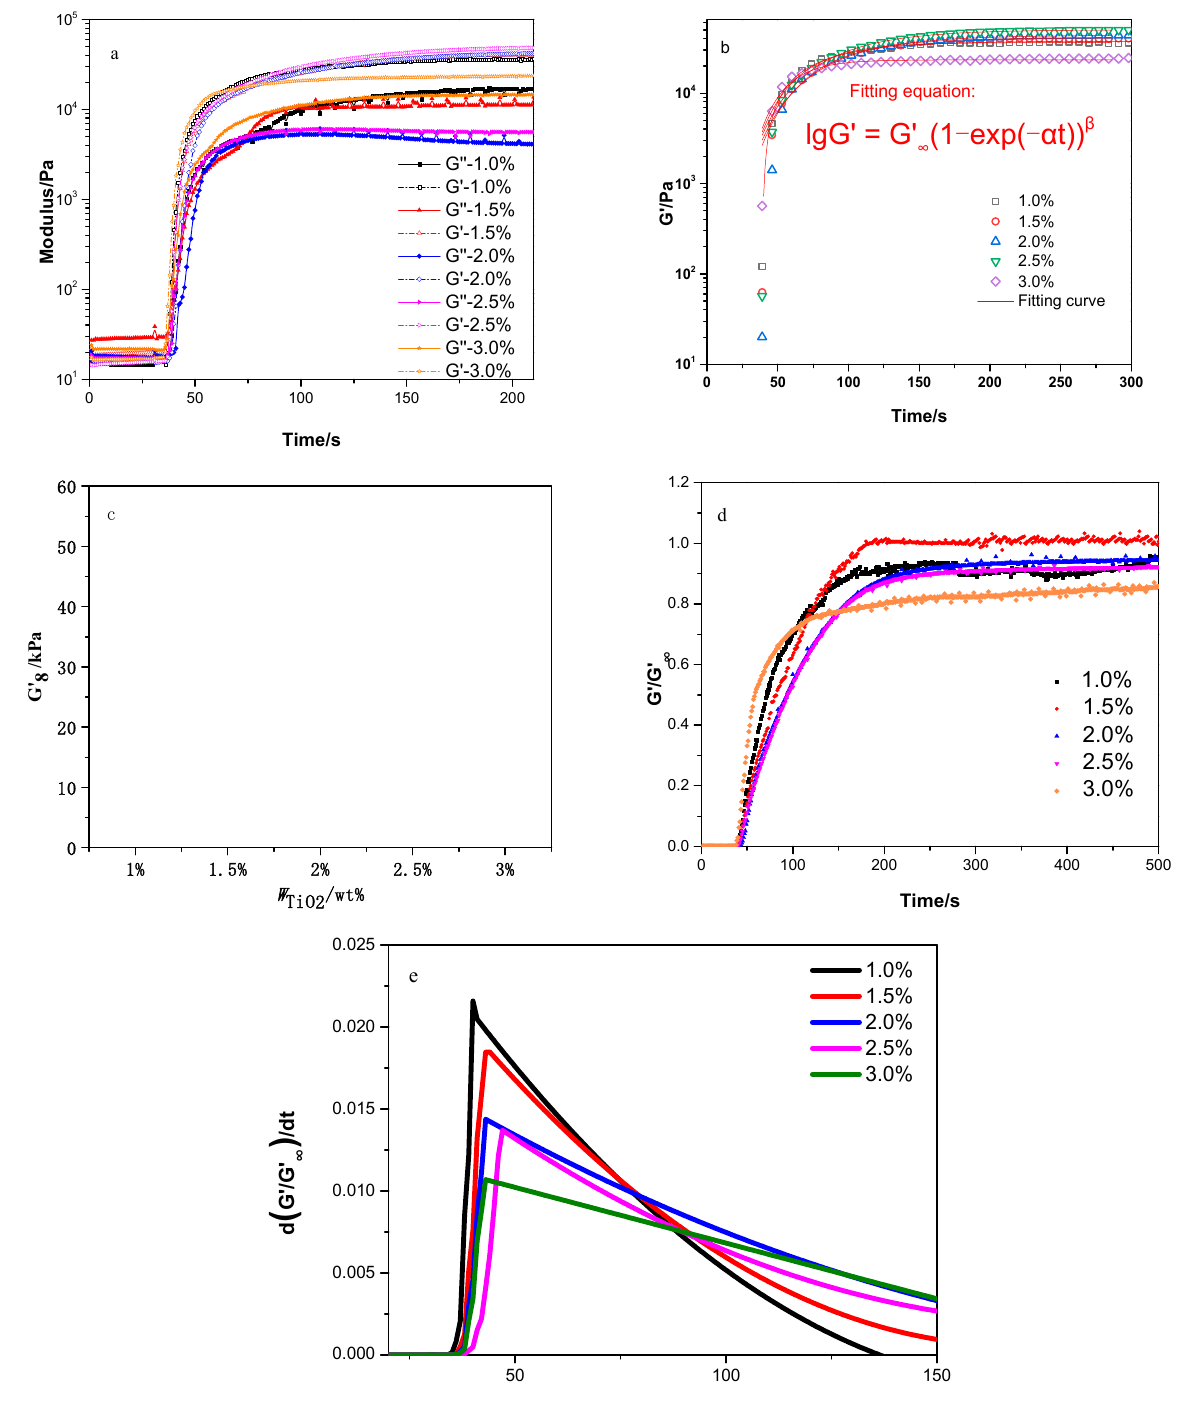
Figure 12. Blue light-induced photo-rheological characteristics of PU-TiO 2 ink. ( a ) Evolution of G ′ and G ″ , ( b ) photo-rheological kinetics, ( c ) G’ ∞ , ( d ) cross-linking degree and ( e ) cross-linking rate.